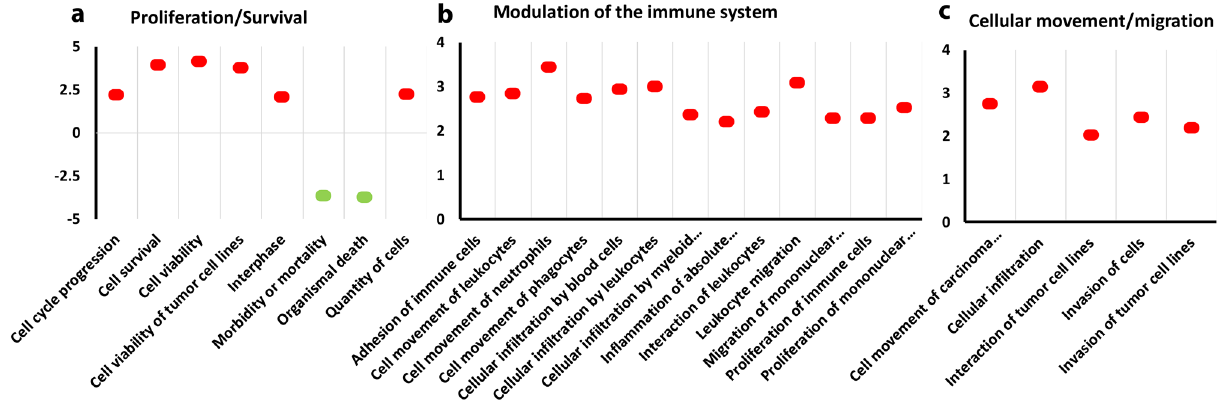
Figure 5. Predicted functions of A549/DDP cells. Bioinformatic analysis predicted functions of the A549/DDP cells based on the RNA-seq data and gene dysregulation level. The functions were categorized in three groups, Proliferation/survival, Modulation of the immune system and Cellular movement/migration. Here shown only functions with |z|> 2 and p <